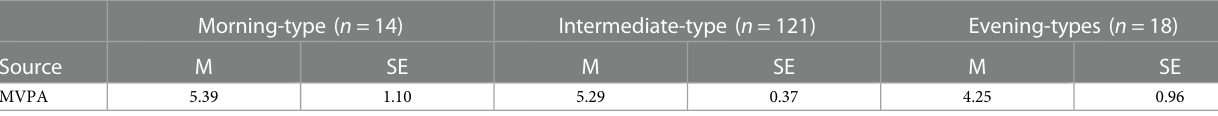
Table 8 presents adjusted means and standard errors for MVPA from the MANCOVA model predicting physical activity (MVPA) by chronotype, controlling for covariates (age, sex, education, and BMI). MVPA did not signi fi cantly differ between chronotype groups, F (2, 146)=0.52, p =.595, partial η 2 =.01 (observed power=.14). MVPA, moderate to vigorous physical activity; BMI, body mass